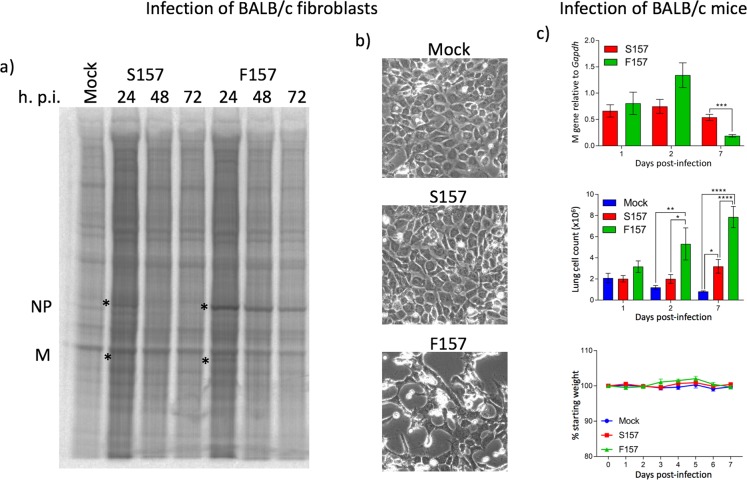
Lytic variants of PIV5 grow to higher titres in mice and induce more inflammation but are cleared more rapidly than persistent variants.Panel a) Monolayers of BALB/c fibroblast cells were either mock infected or infected with rPIV5-W3:P(S157) or rPIV5-W3:P(F157) at 10 pfu/cell. At the times indicated cells were metabolically labelled for 1h with [35S]-L-methionine. Polypeptides present in the total cell extracts were separated by electrophoresis through a 4–12% SDS-PAG, and the labelled polypeptides visualized using a phosphorimager. Panel b) At the time of labelling at 72h p.i. images of the monolayers were taken using a phase contrast microscope. Note the lack of a cpe at 72h p.i. in cells infected with the rPIV5-W3:P(S157) in contrast to cells infected with rPIV5-W3:P(F157). Panel c) BALB/c mice were infected with either rPIV5-W3:P(S157) or rPIV5-W3:P(F157). At 1, 2, and 7 days p.i. 5 mice were sacrificed, and the amount of virus present estimated by quantitative PCR (top panel) and the lung cell count measured (middle panel); their body weight was also measured daily until 7 days p.i. (bottom panel).